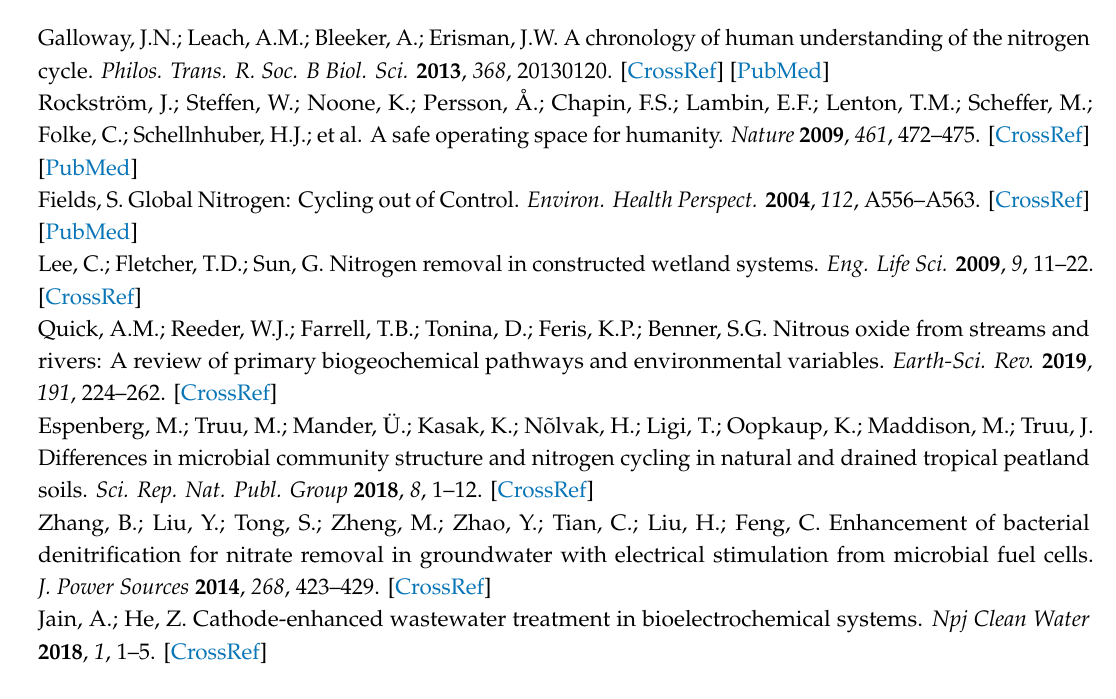
Figure S5. Di ff erent cyclic voltammograms of carbon felt i.e., graphite felt before and after Sodium Nitrate addition in the electrolyte under helium saturation and ambient air. Possible nitrate reduction is showed by blue